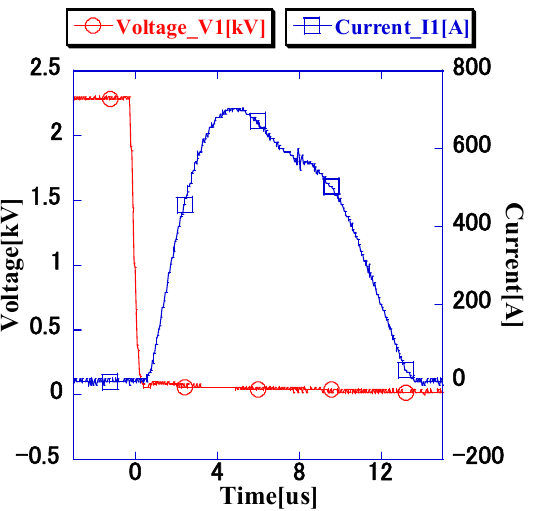
Figure 4. Voltage and current waveforms of the primary side. A current of approximately 728 A flowed through the semiconductor for 0.8 μ s after the voltage applied to the semiconductor reduced.